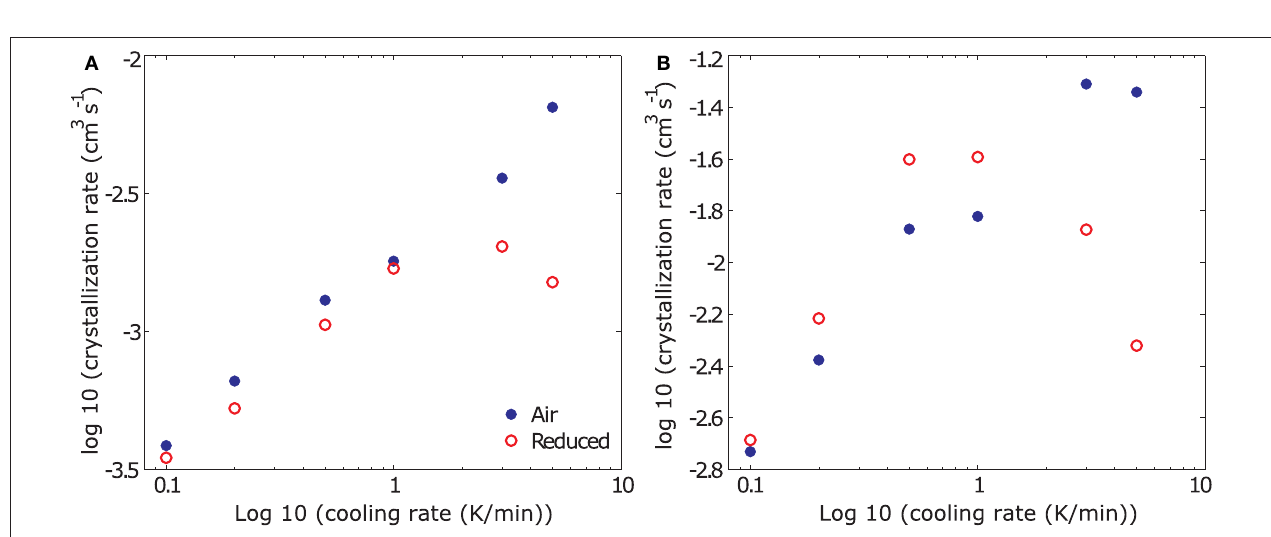
FIGURE 7 | Results from the deduction of the crystallization kinetics from rheological data. The data shown in these example plots are from dynamic crystallization experiments at a cooling rate of 0.2 K/min. (A) Evolution of crystal volume fraction deduced from the rheological data as a function of temperature and comparison to equilibrium models at the Ni-NiO and QFM + 1 buffers. Crystal fraction ( 8 ) reconstructed for aspect ratios and resulting 8 m of 1–5. (B) Evolution of crystal volume fraction deduced from the rheological data as a function of time.